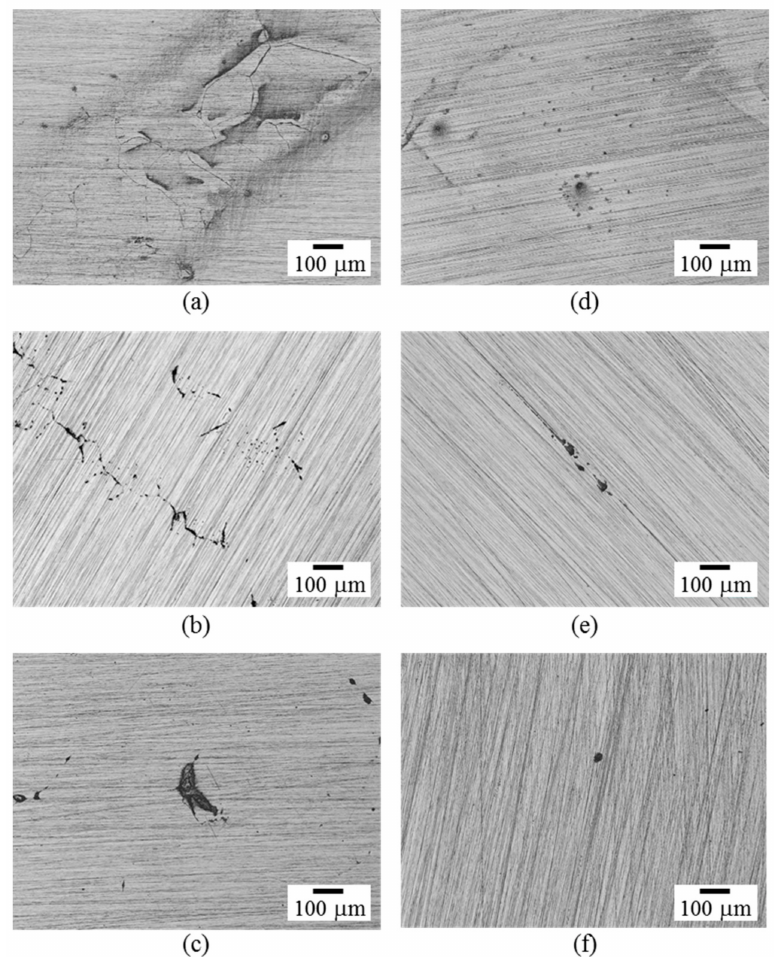
Figure 4. Laser microscopy images showing pitting of test specimens for CG alloys with ( a ) 8%, ( b ) 10% and ( c ) 12% Cr and UFG alloys prepared by ECAP with ( d ) 8%, ( e ) 10% and ( f ) 12%